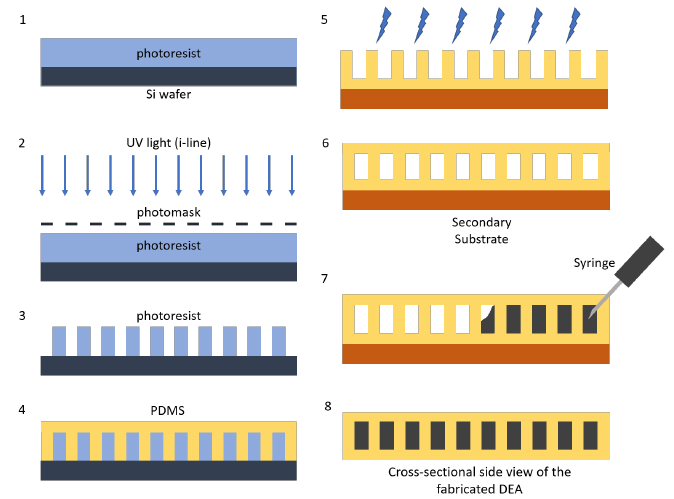
Figure 9. Schematic depicting the process flow for the injection molding approach (Method III). Drawings in the figure are not to scale and represent the cross-sectional side views at the center of each structure.